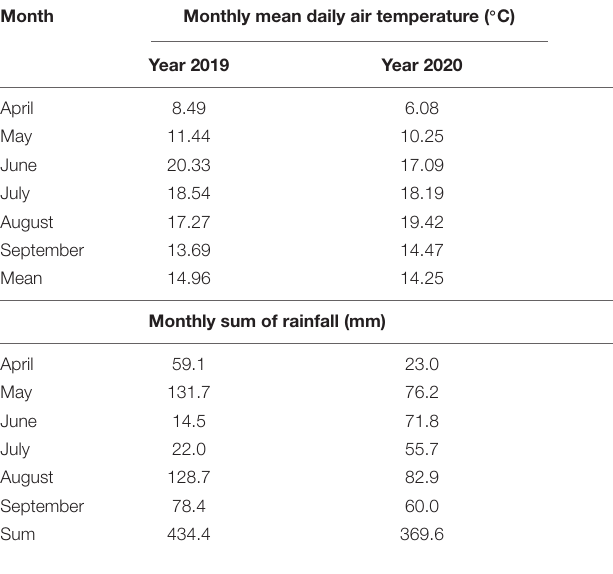
TABLE 3 | Meteorological data for the carrot cultivation period in 2019 and